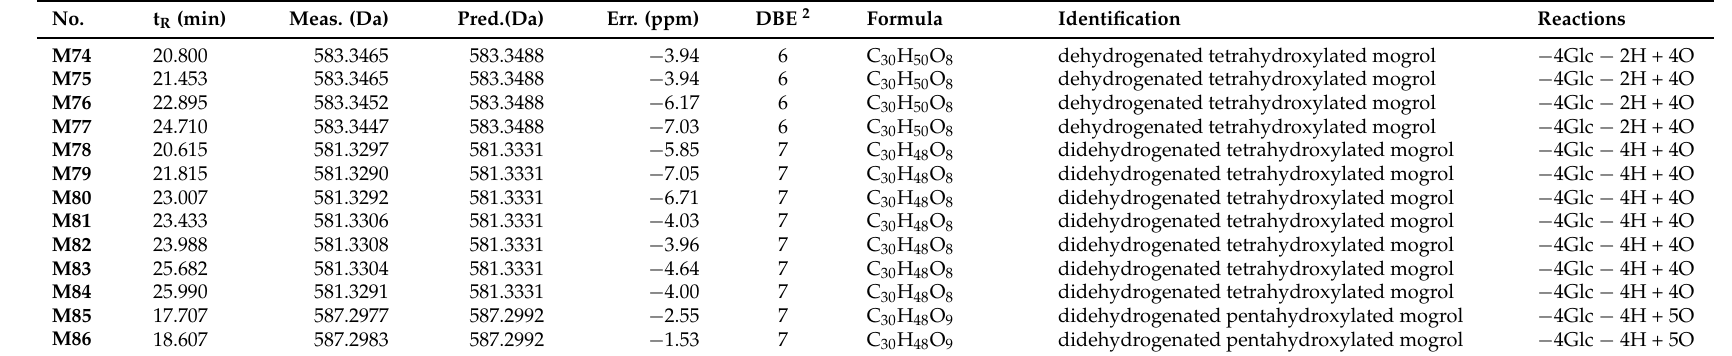
1 Confirmed by comparison with reference compounds. 2 DBE, double bond